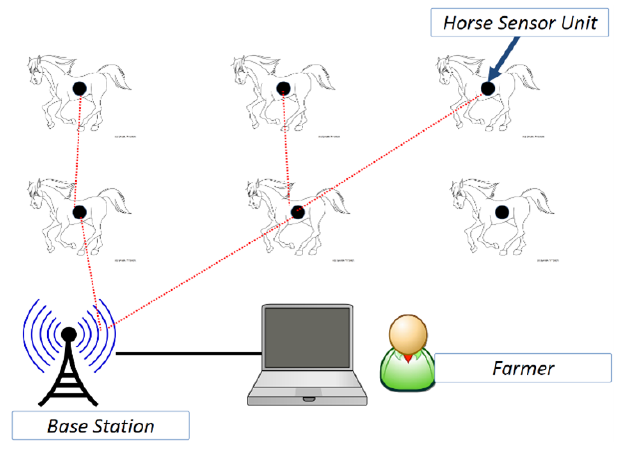
Figure 3. IoT system for monitoring olive trees in a fixed position.